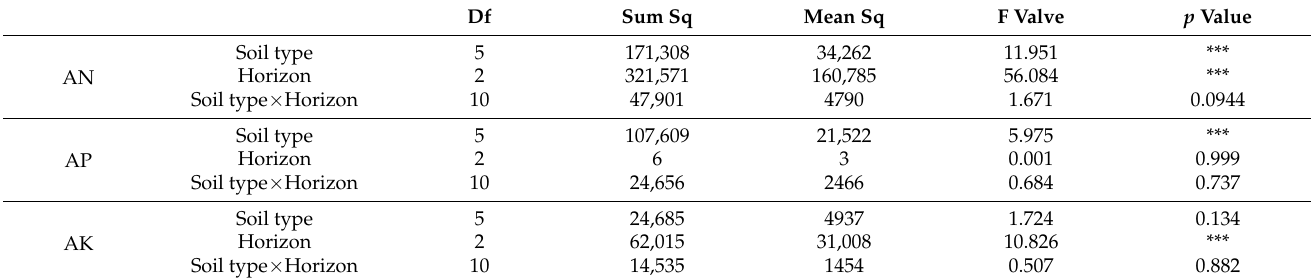
Table 2. Two-way ANOVA of soil-available nutrients. *** indicates significant differences at p < 0.01. Df Sum Sq Mean Sq F Valve p Value